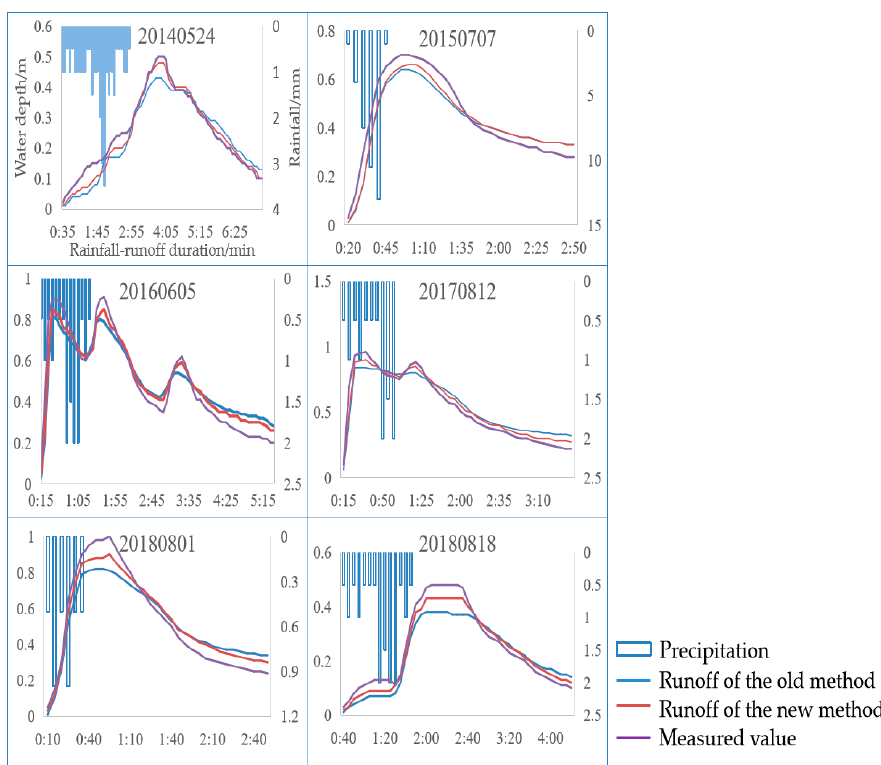
Figure 12. Comparison of simulation results of two methods for six rainfall events.